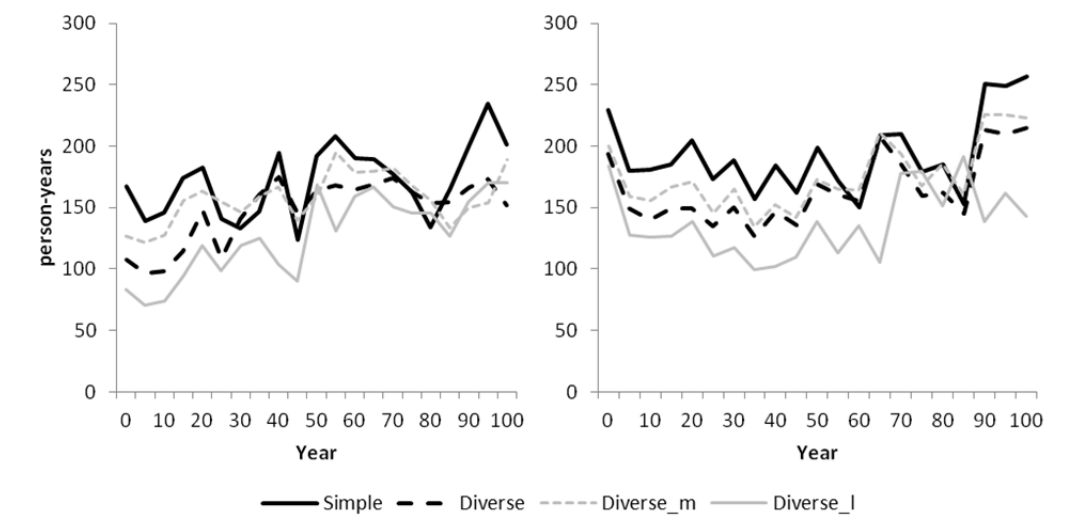
Figure 13. Person-years needed for forest management activities in Hässleholm ( left ) and Vilhelmina ( right ), for the Simple and Diverse scenarios, as well as the more intensive (Diverse_m) and less intensive (Diverse_l) variations of the Diverse